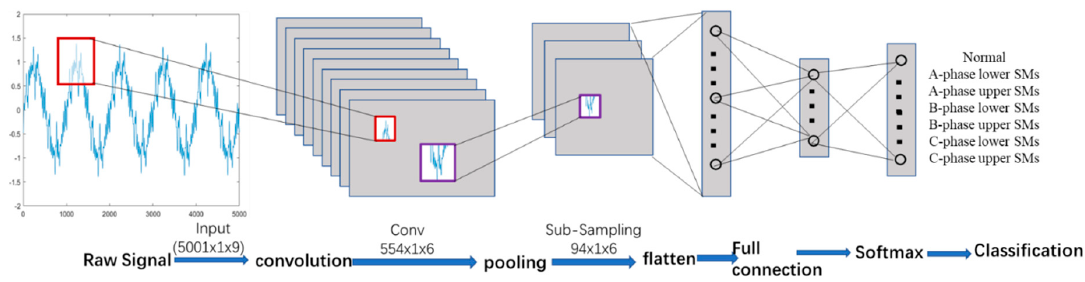
Figure 4. Architecture of the signal-level CNN classifier